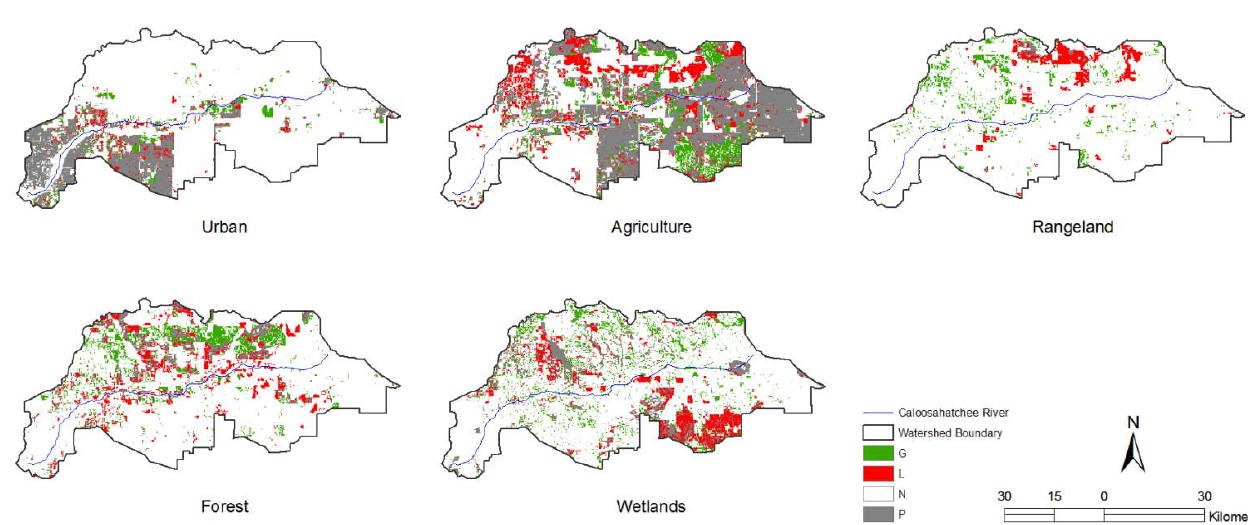
Figure 3. Gains (G), losses (L) and persistence (P) of land uses in the Caloosahatchee River Watershed between 1988 and 1999 based on existing data. Areas not in the land use concerned are represented as “N”.